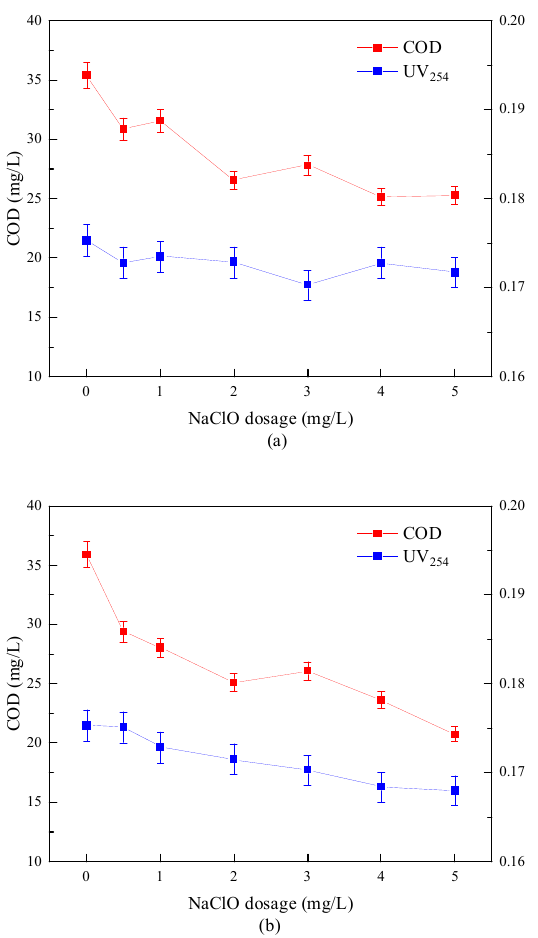
Figure 9. Removal effect of combined disinfection method on COD and UV 254 . ( a ) “Method A”; ( b ) “Method B”.